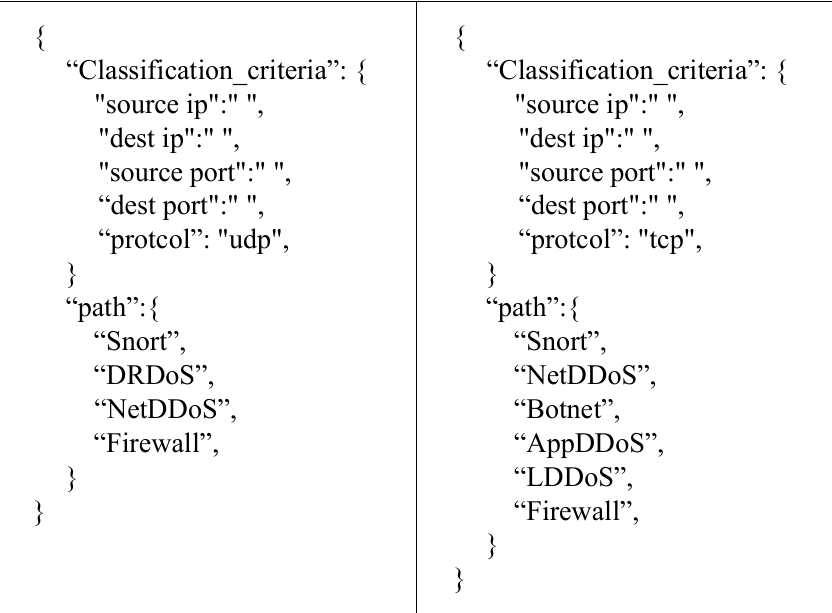
Figure 11. Path policies under UDP and TCP.